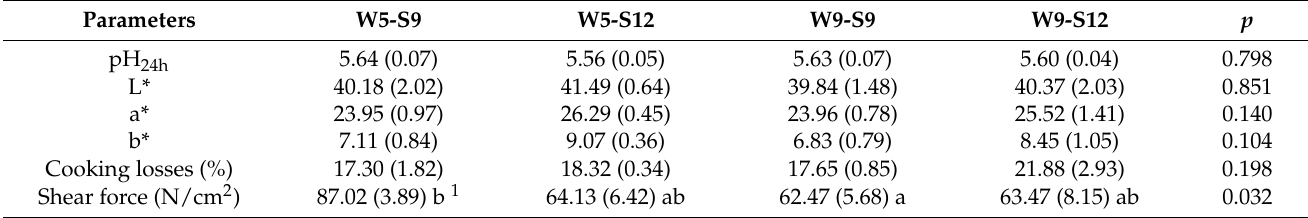
Table 1. Physicochemical parameters of meat quality (mean and standard